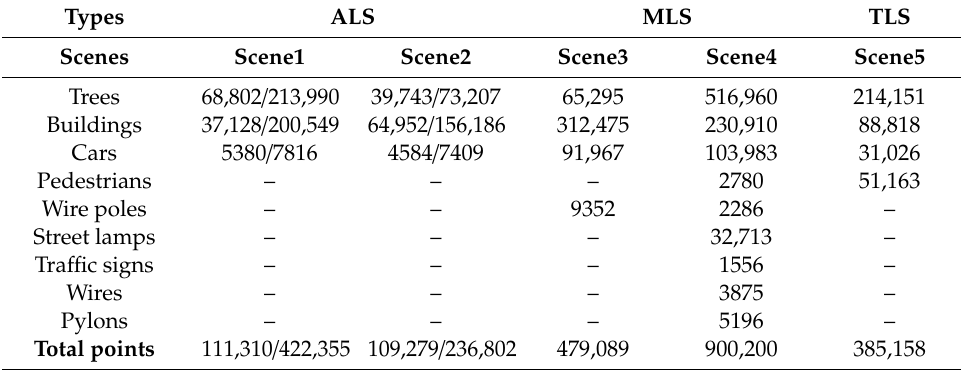
Figure 3. Five different point cloud scenes used in this paper. Subfigures from ( a ) to ( e ) represent the scanned Scene1 to Scene5. Table 1. Statistics of five point cloud datasets used in this paper. For airborne laser-scanning (ALS) point clouds, the number of training set and the test set are separated by symbol “ / ”. The symbol “–” represents the corresponding class does not exist.